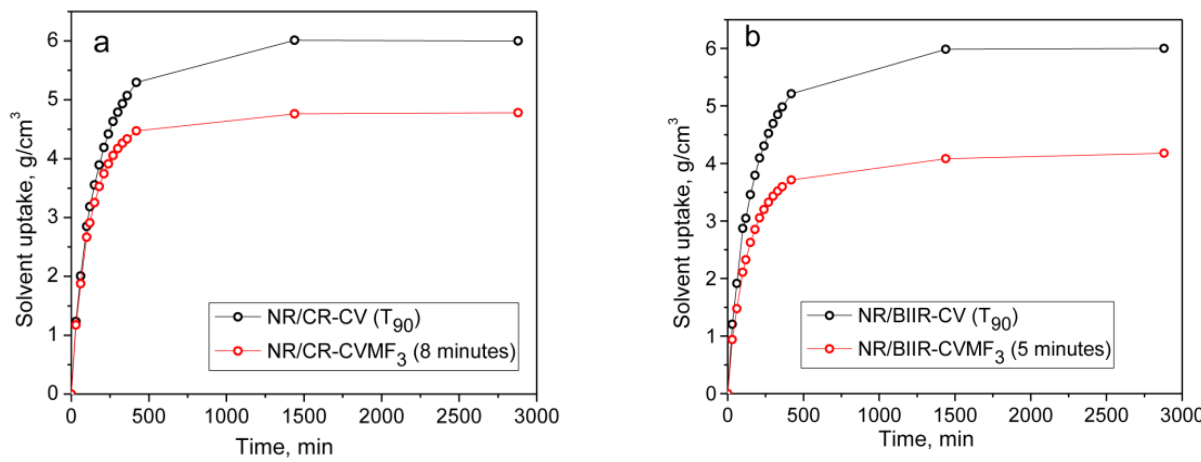
Figure 8. The solvent uptake of ( a ) T 90 cured NR/CR-CV and 8 min cured NR/CR-CVMF 3 ( b ) T 90 cured NR/BIIR-CV and 5 min cured NR/BIIR-CVMF 3.